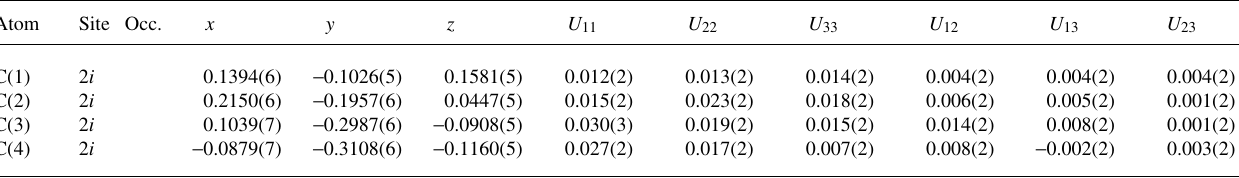
Table 3. Atomic coordinates and displacement parameters (in Å 2 ) . Atom Site